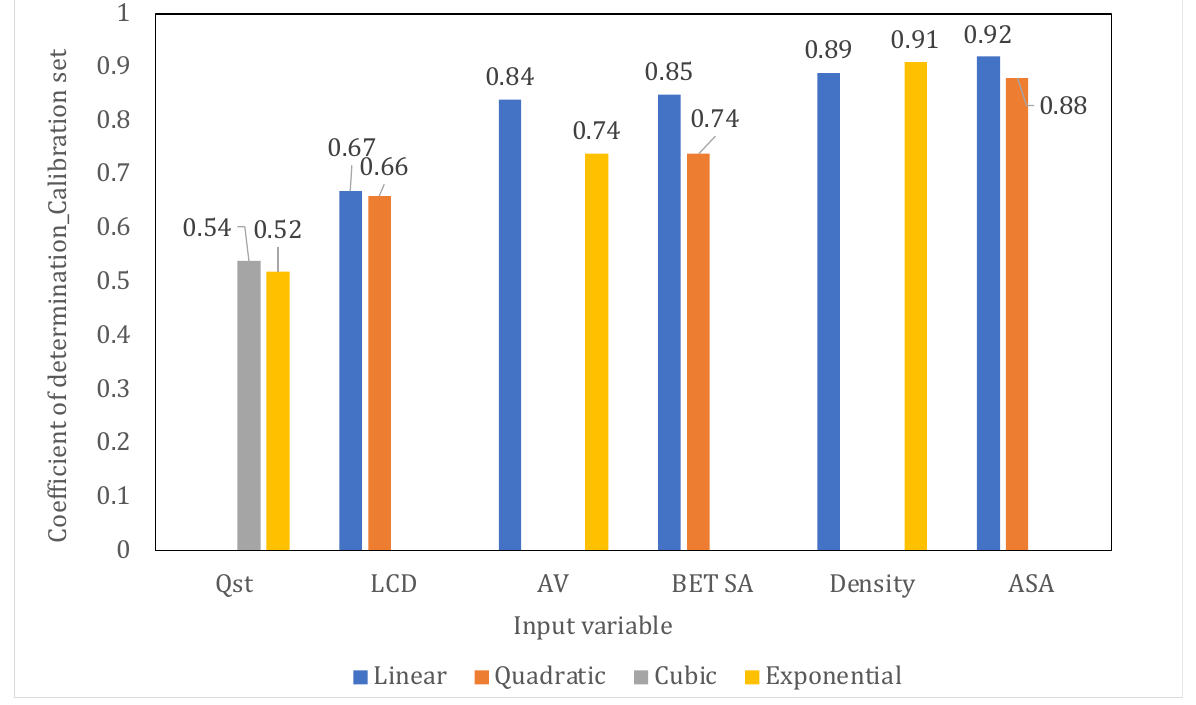
in Table 4, above: the top two best-performing fits for C